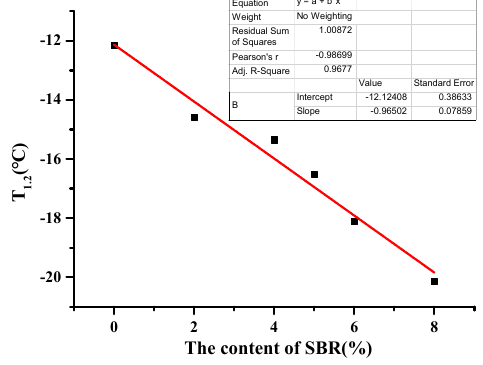
Figure 9. Fitting curves of SBR content and equivalent brittle point.